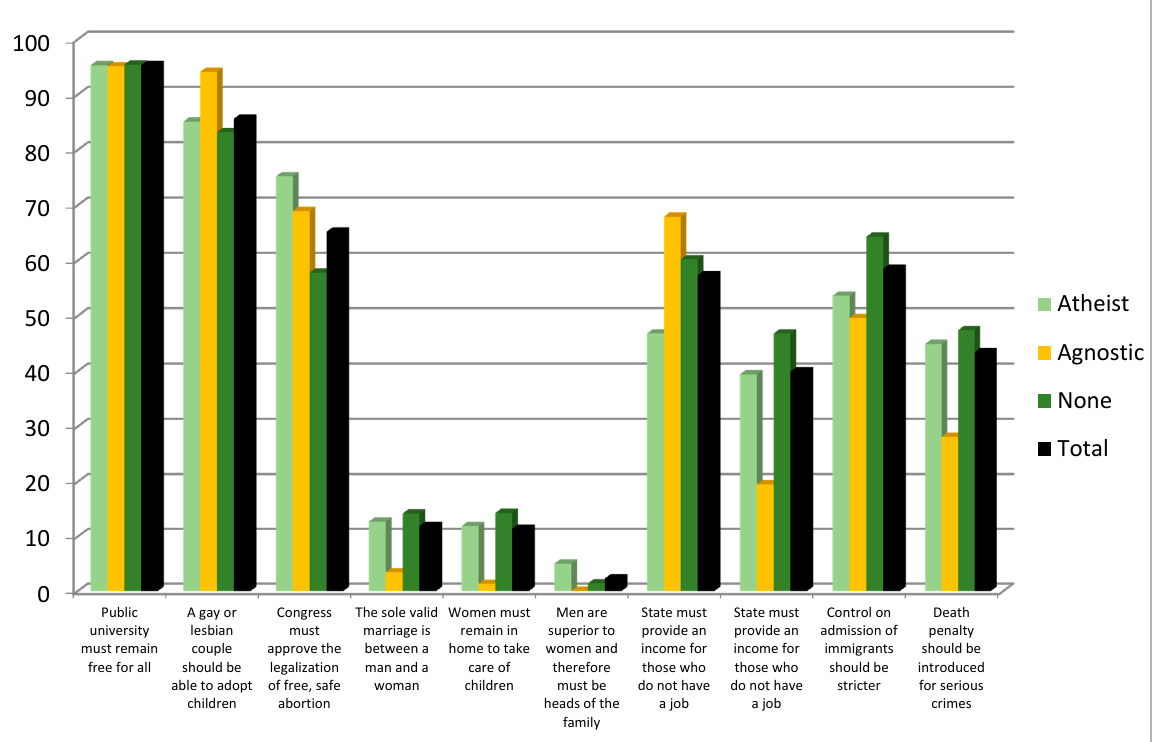
Figure 12. Opinion on society, family, and household issues (in %). Based on 382 cases. Source: Author’s elaboration based on the Second National Survey on Religious Beliefs and Attitudes. Society, Culture and Religion Program, CEIL-CONICET, 2019.